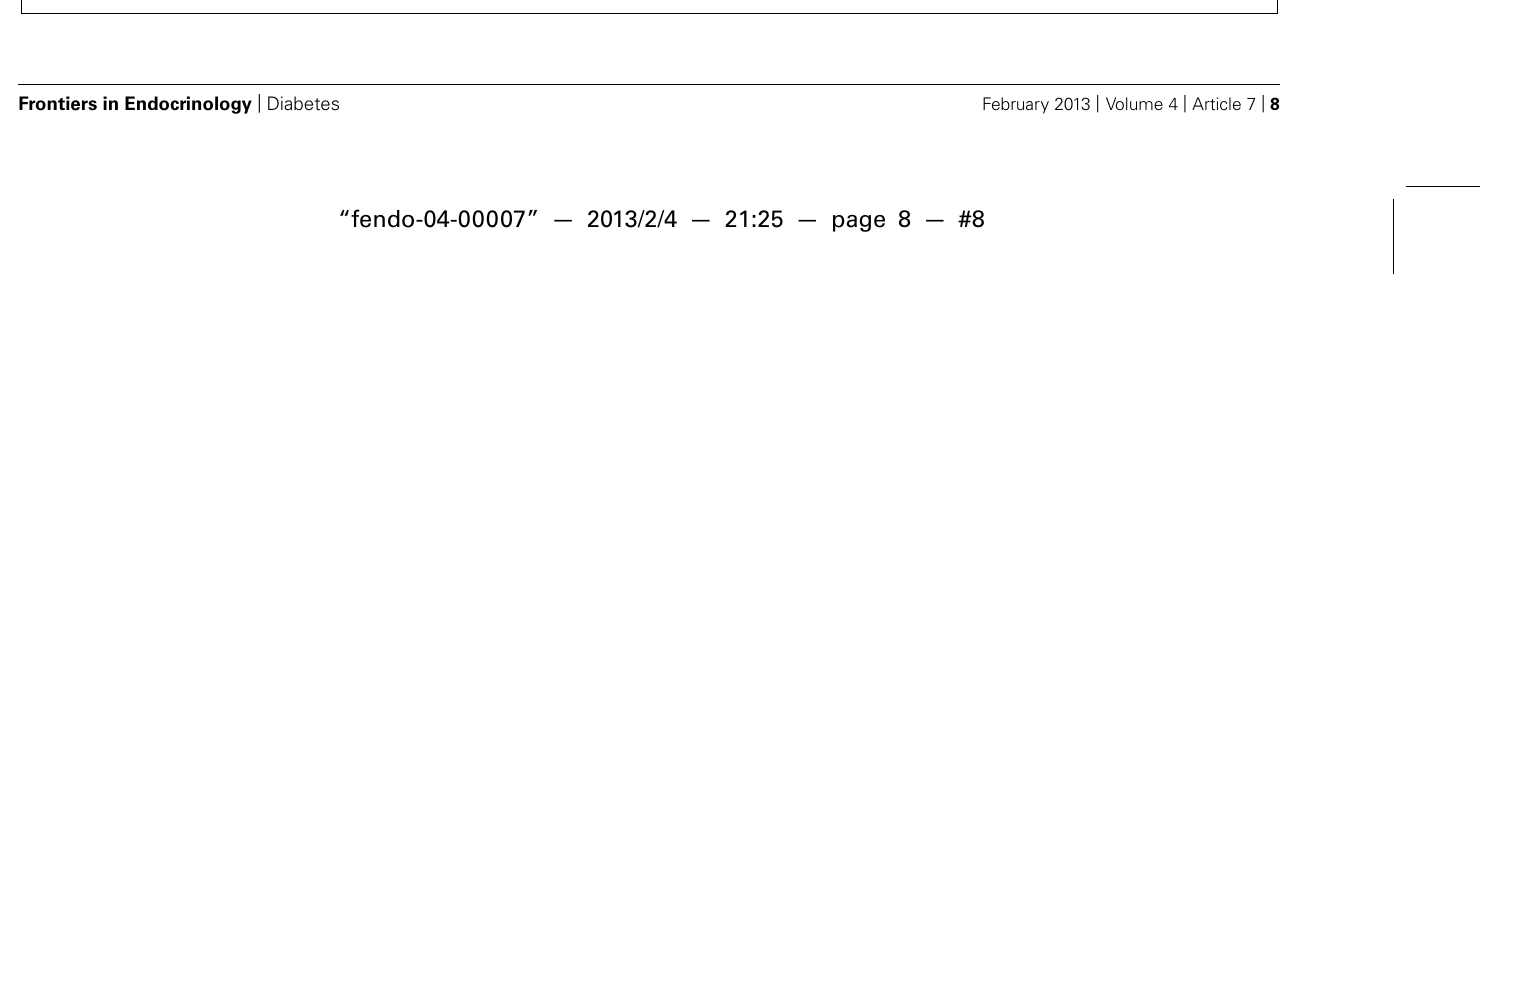
Frontiers in Endocrinology |